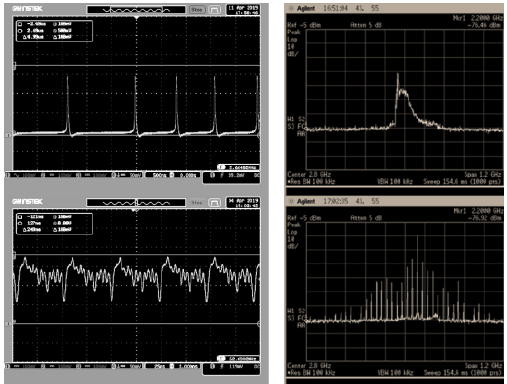
Fig. 7. Auto-transitions on the boundary of